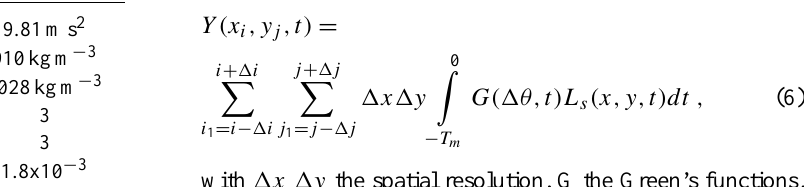
Table 1. Ice sheet–bedrock model parameter values. Parameter